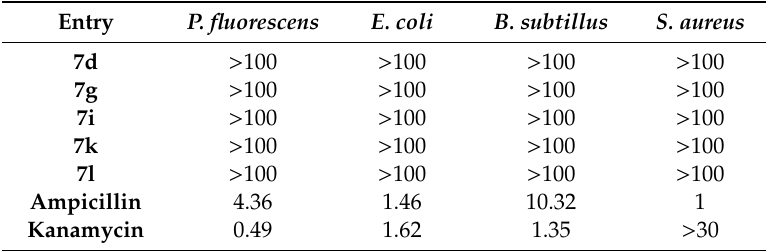
Table 4. Antibacterial activity IC 90 ( µ g /